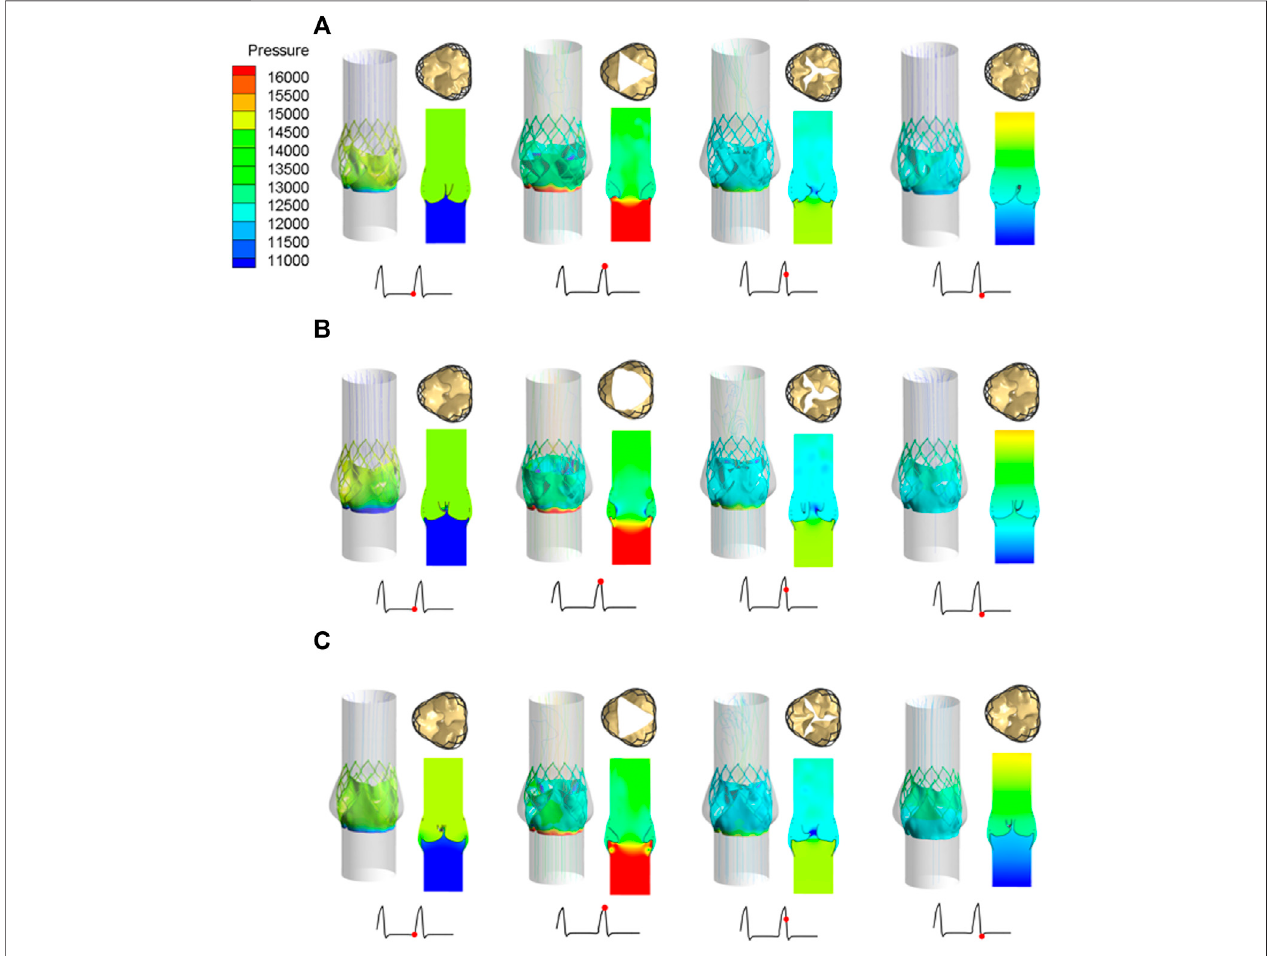
FIGURE8| Lea fl etopening andclosingstatesandpressuredistribution diagramsatfourdifferent fl owstages, (A) valvestentmodelA, (B) valvestentmodelB, (C) valve stent model C.